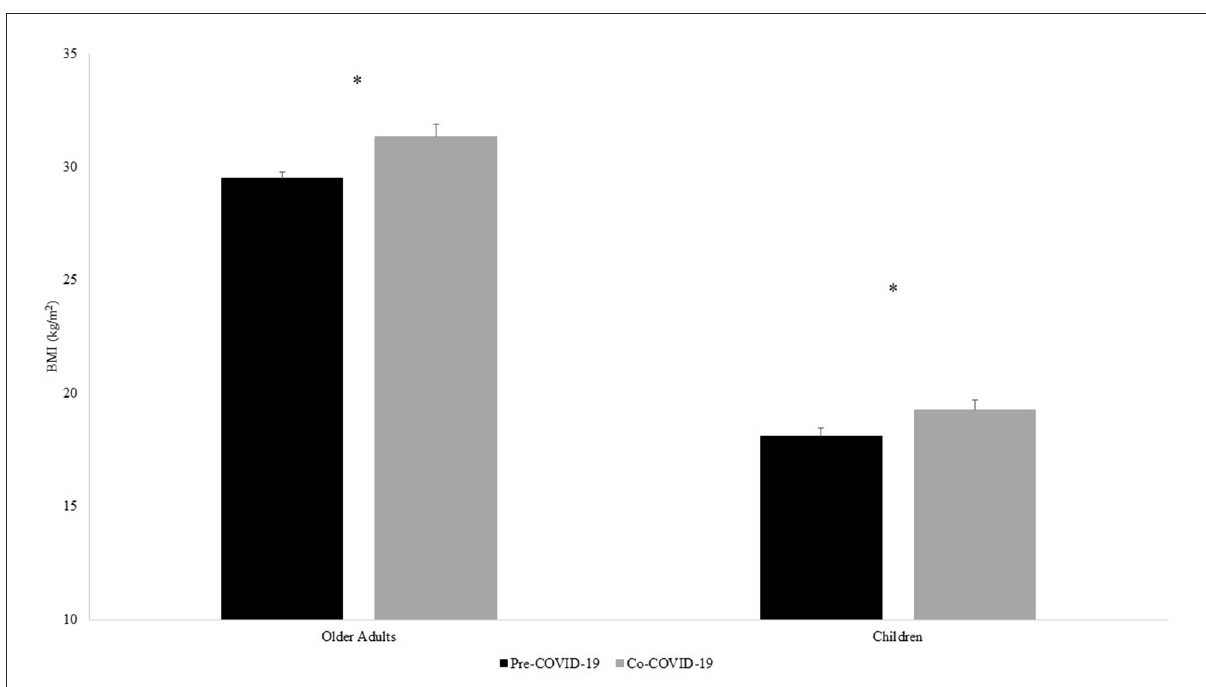
FIGURE2 BMI (Means ± Standard Error) for Pre- and Co-COVID children and older adults. *T-test is significant at p ≤ 0.05.